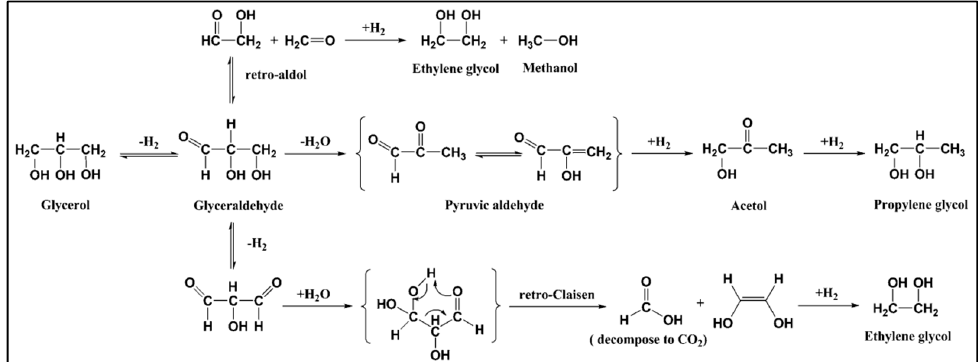
Figure 7. Glycerol dehydrogenation, dehydration, and hydrogenation to 1,2-propanediol using an alkali support. Reprinted/adapted with permission from Wang and Liu [96], Wiley, 2010.